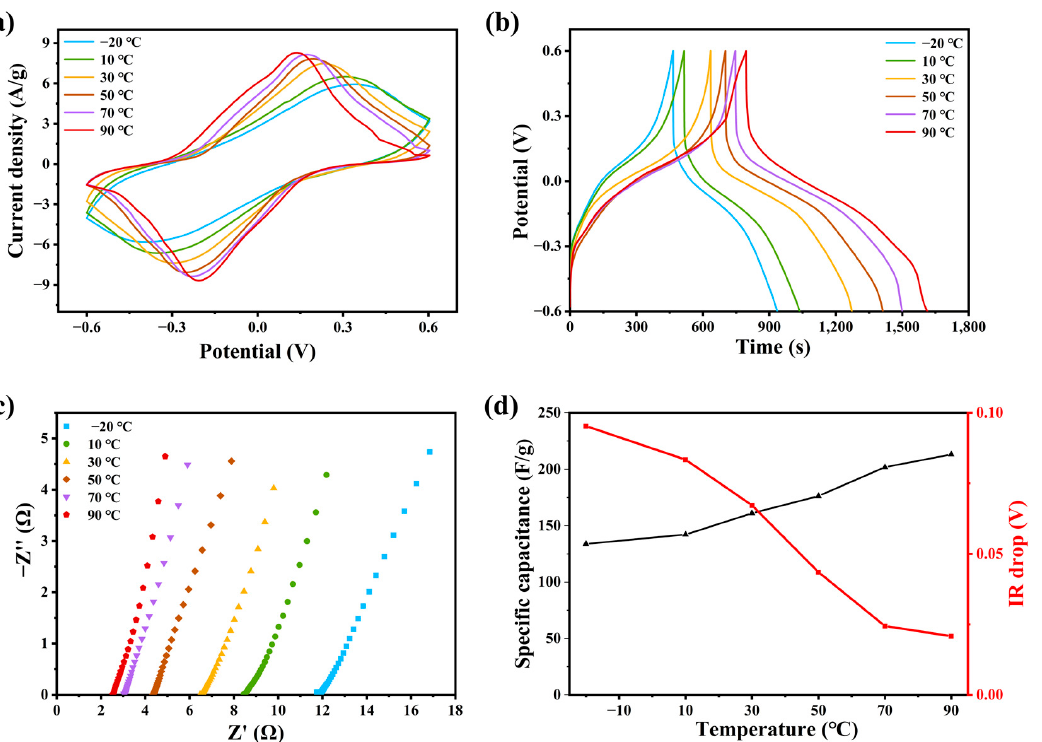
Figure 5. ( a ) The CV curve of PAIMSC with scanning rate of 20 mV/s at different temperatures from − 20 ◦ C to 90 ◦ C; ( b ) GCD curves of PAIMSC at current densities of 0.25 mA/g; ( c ) different Nyquist curves of PAIMSC; ( d ) specific capacitance and IR drop at different temperatures .